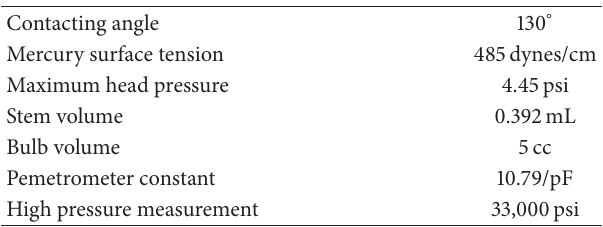
Table 3: Measuring conditions for MIP test.